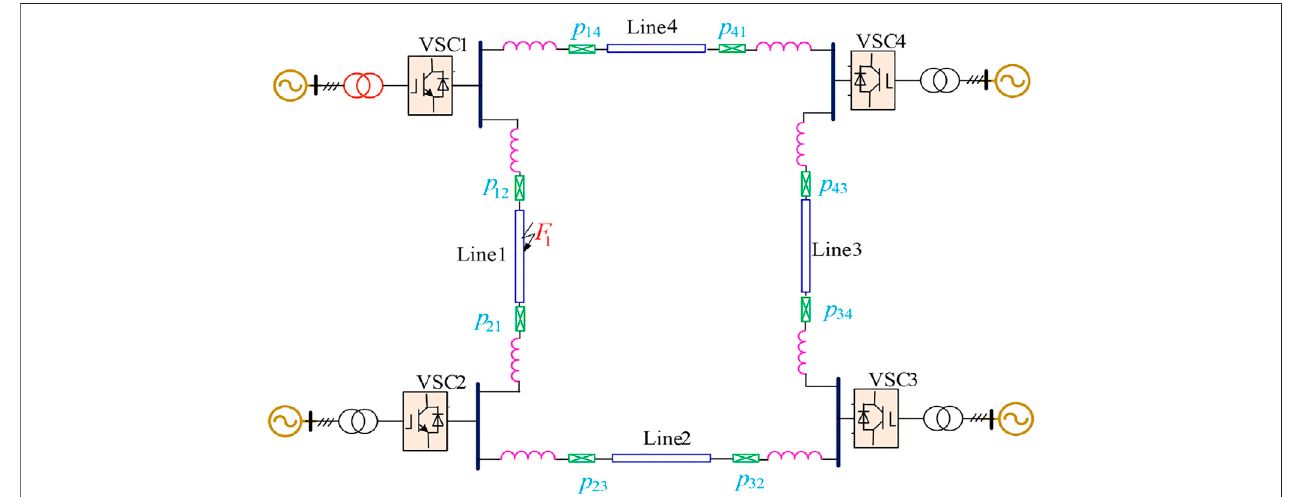
FIGURE 4 | Schematic diagram of line failures of four-terminal fl exible DC